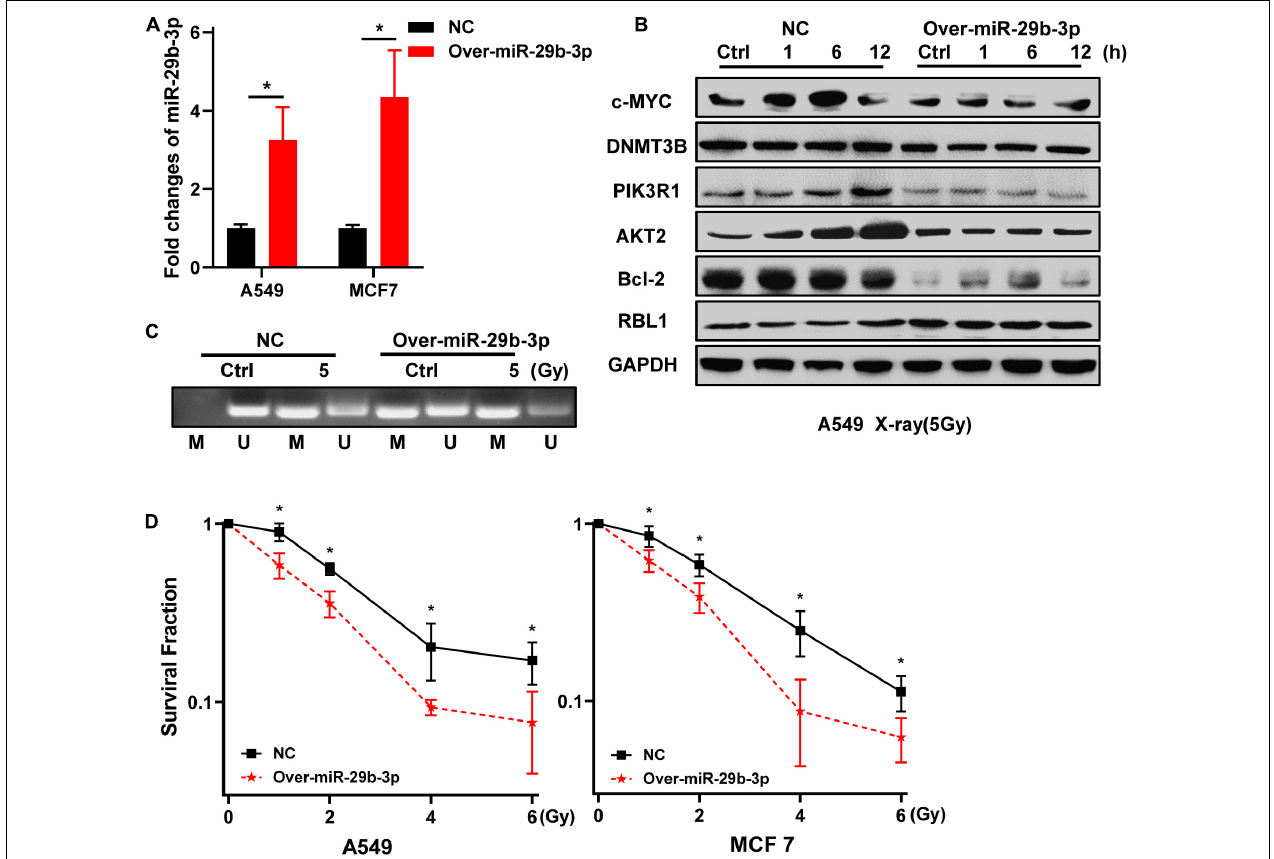
FIGURE 4 | Overexpression of miR-29b-3p sensitizes the 3D cultured A549 and MCF7 cells to radiation. (A) Relative expression of miR-29b-3p measured by qRT-PCR in 3D culture miR-29b-3p overexpressed A549 and MCF7 cells. (B) Western blot assay on the expression of c-MYC, DNMT3B, PIK3R1, AKT2, Bcl-2 and RBL1 at indicated time points after 5 Gy X-rays in 3D cultured miR-29b-3p overexpressed A549 cells. (C) The changes of the promoter methylation status of RBL1 measured by MSP in 5 Gy X-ray irradiated and unirradiated 3D cultured miR-29b-3p overexpressed A549 cells. (D) Colony formation assay on the 3D cultured miR-29b-3p overexpressed A549 and MCF7 cells after exposure to 0, 1, 2, 4 and 6 Gy X-rays. Ctrl, unirradiated groups; NC, negative control. Significance was determined by unpaired t -test. * P <